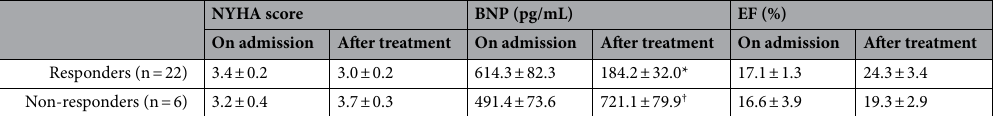
Table 3. NYHA score and BNP levels in patients on admission and after treatment. The New York Heart Association functional classification (NYHA) score, serum levels of brain natriuretic peptide (BNP) and left ventricular ejection fraction (EF) were determined in patients on admission and after treatment. The data after treatment were obtained 82.0 ± 13.7 and 43.2 ± 11.1 days after admission in responders and non-responders, respectively (P = 0.173). Data are expressed as mean ± sem. *P < 0.0001 compared to values on admission. † P = 0.0003 compared to values of the responders. Repeated two-way ANOVA followed by Bonferroni’s post hoc test was used.